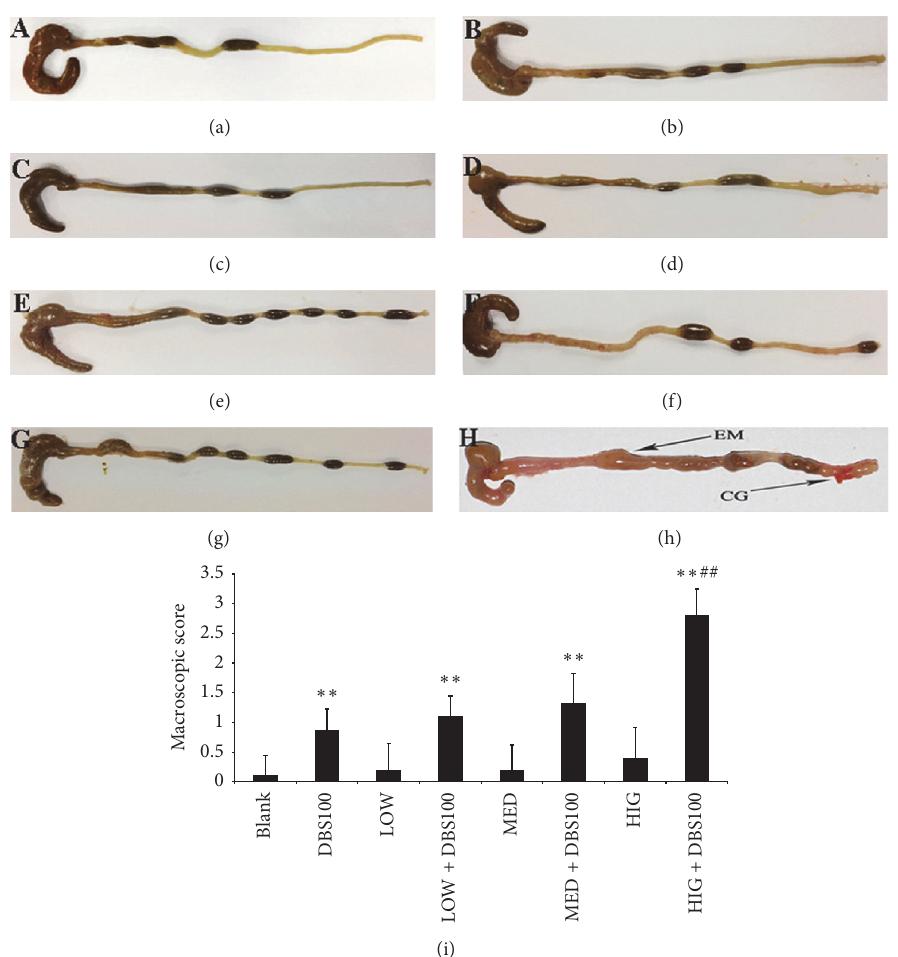
Figure 6: The impact of 𝜅 -carrageenan on colon damage following Citrobacter freundii DBS100. (a) Blank group; (b) DBS100 treated alone; (c) LOW treated alone; (d) LOW + DBS100 cooperative accessing; (e) MED treated alone; (f) MED + DBS100 cooperative accessing; (g) HIG treated alone; (h) HIG + DBS100 cooperative accessing; (i) colon damage scores at 10 days after DBS100 administration. ∗∗ 𝑃 < 0.01 , compared with the blank group. ## 𝑃 < 0.01 , compared with the C. freundii DBS100-treated group. CG, congestion; EM, edema.